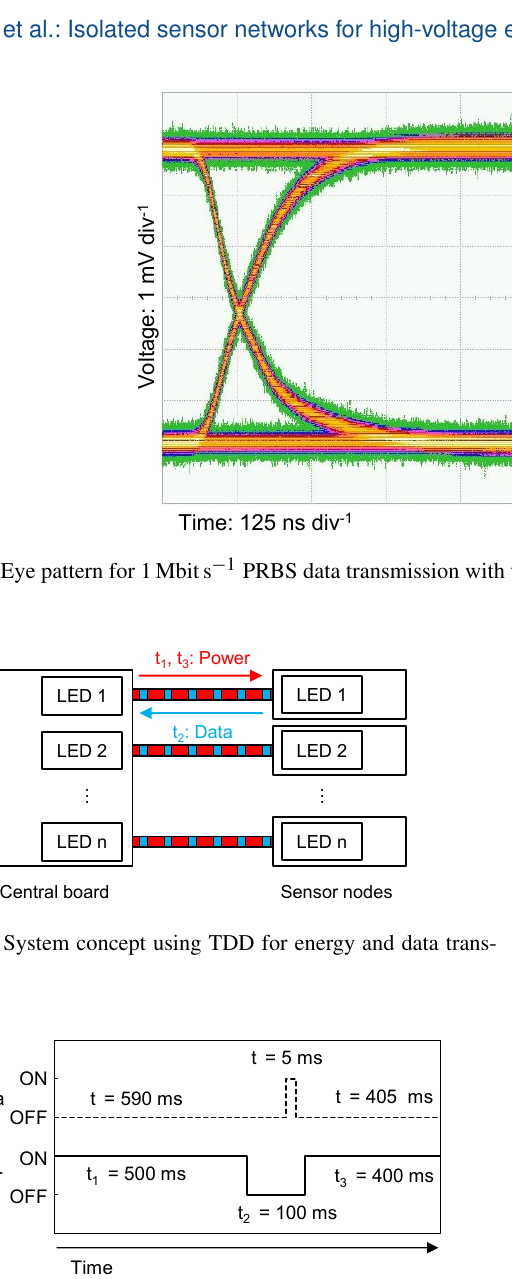
Figure 17. Timing diagram for the power and data transmission with a period of 1s.